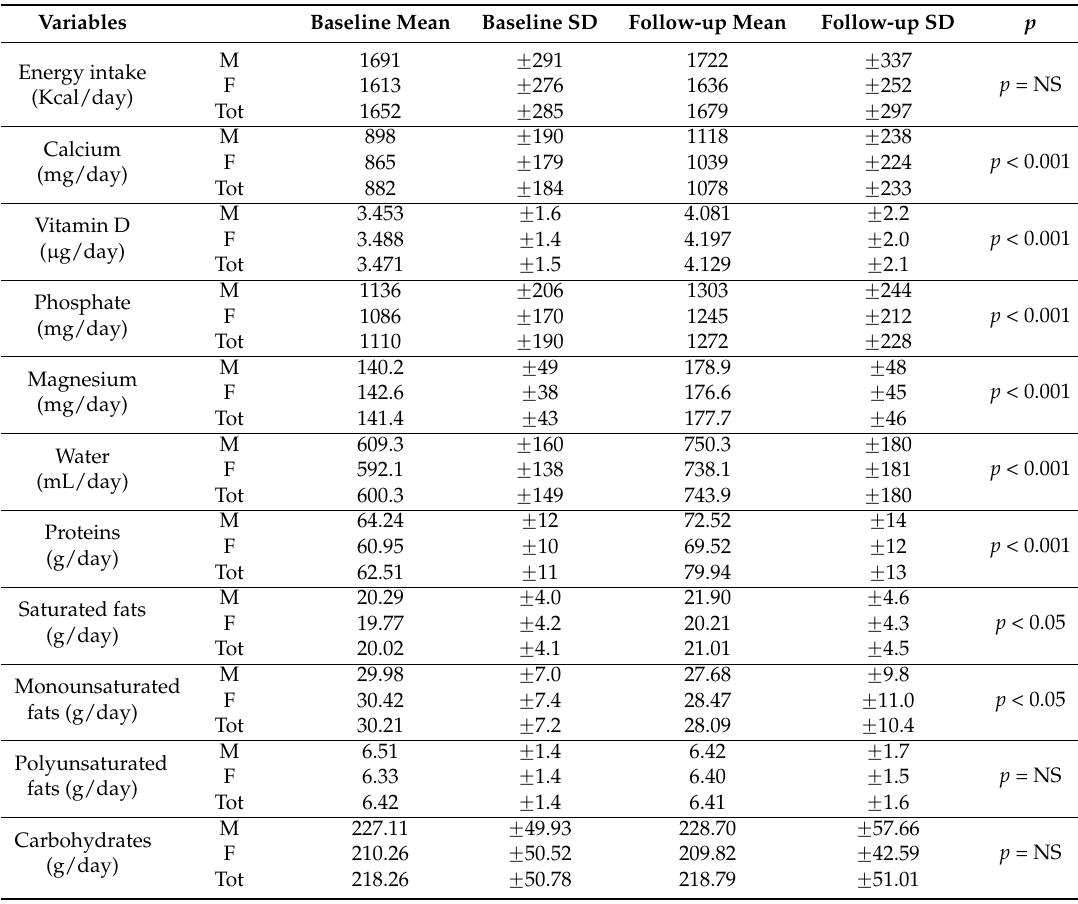
Table 2. Mean values of energy intake, and the intake of water, and different macro and micronutrients in males (M), females (F) and the whole population (156) at baseline and follow-up after nutritional intervention.